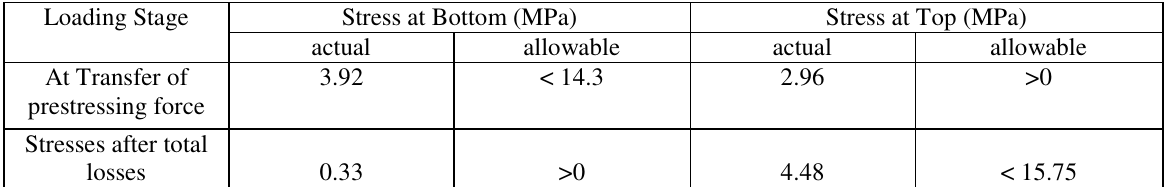
TABLE 5. BOX GIRDER STRESS LIMITS FOR